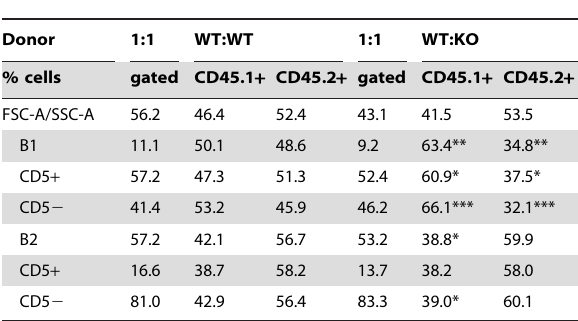
Table 4. FACS analysis of the B cell populations present in the peritoneal cavity three months after competitive bone marrow transplantation.